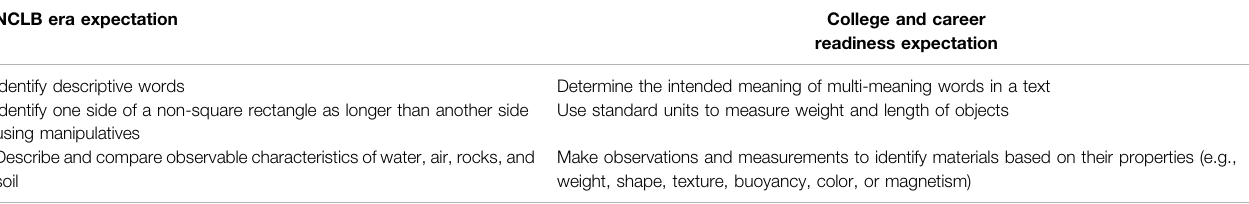
TABLE 1 | Shifts in academic expectations for students with the most signi fi cant cognitive disabilities under NCLB-era standards and current academic content standards, grade 5